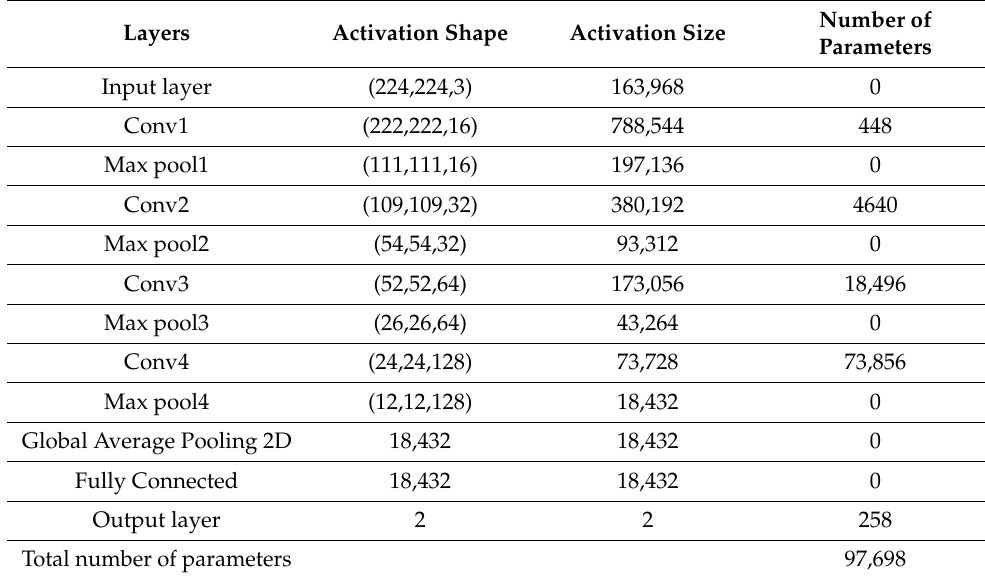
Table 1. The proposed model activation shape, activation size, and